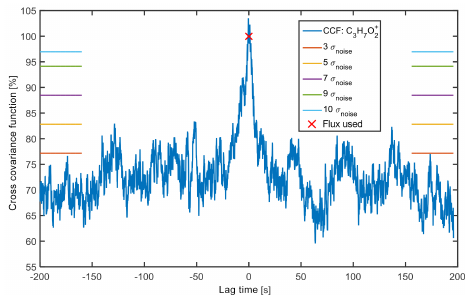
. Due to the con- 2